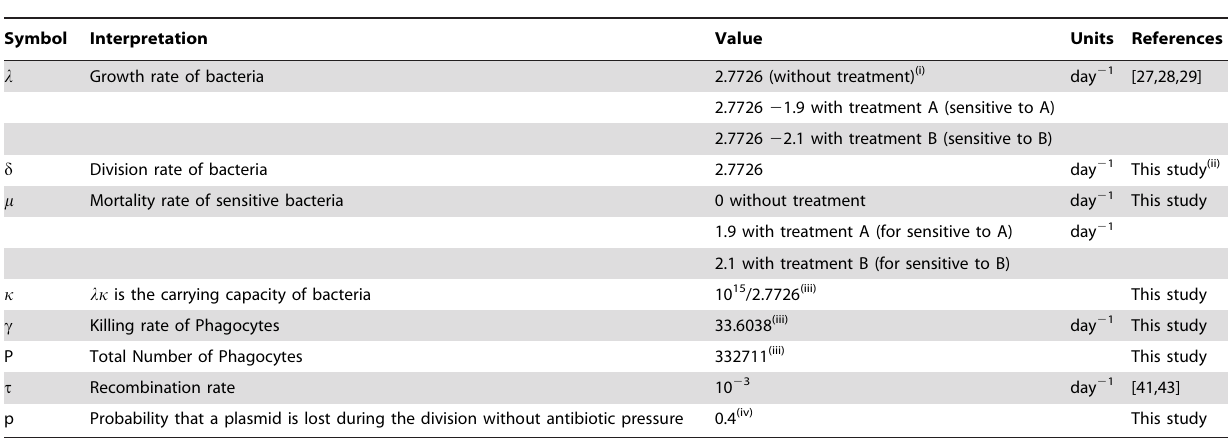
Table 1. List of Parameters and their Values.